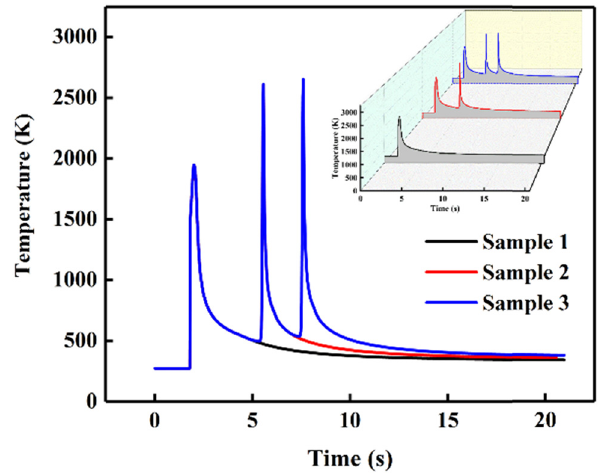
Figure 11: Curve graph of surface vertex temperature